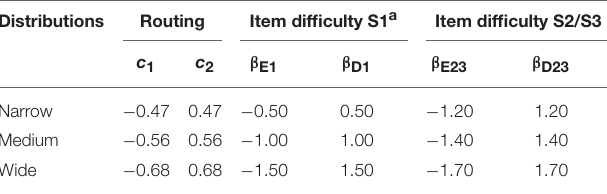
TABLE 2 | Routing cutoff scores and item difficulty parameters of easy and difficult modules in stage 1 and in stage 2/3 per ability distribution